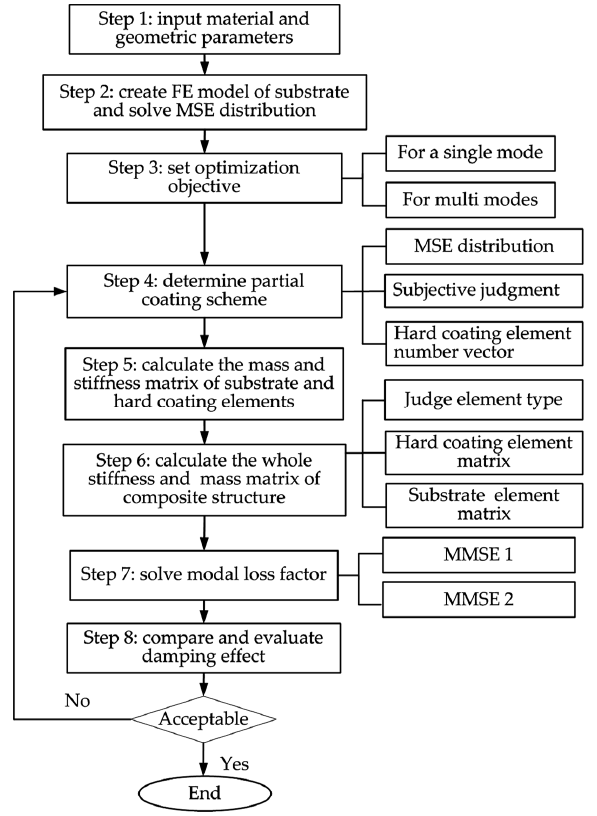
Figure 4. The procedure of damping optimization based on MMSE.